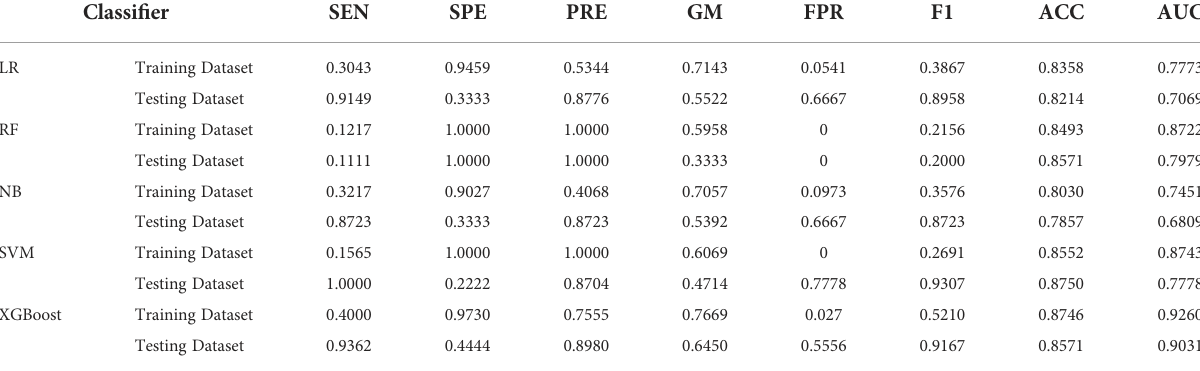
TABLE 4 Evaluation indicators of predictive performance of fi ve models in Triple-negative group and Non-triple-negative group. Classi fi er SEN